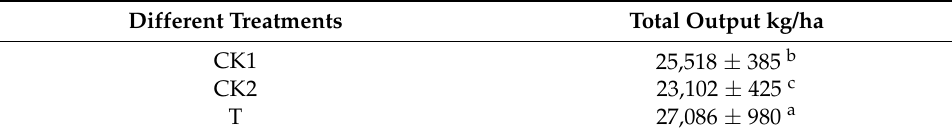
Table 3. Changes in total taro yields under different straw mulching treatments.